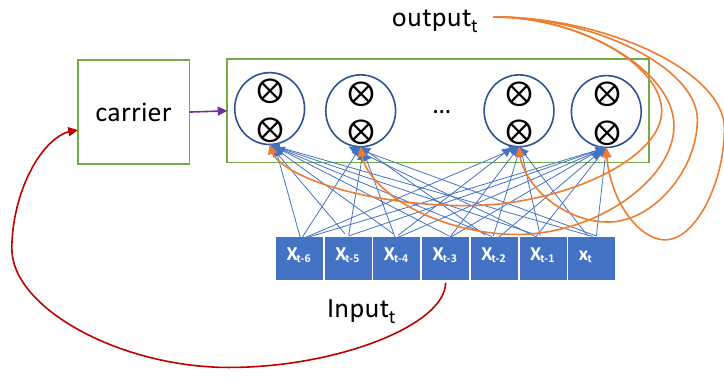
Figure 3. Conceptual description of long-short term memory (LSTM).